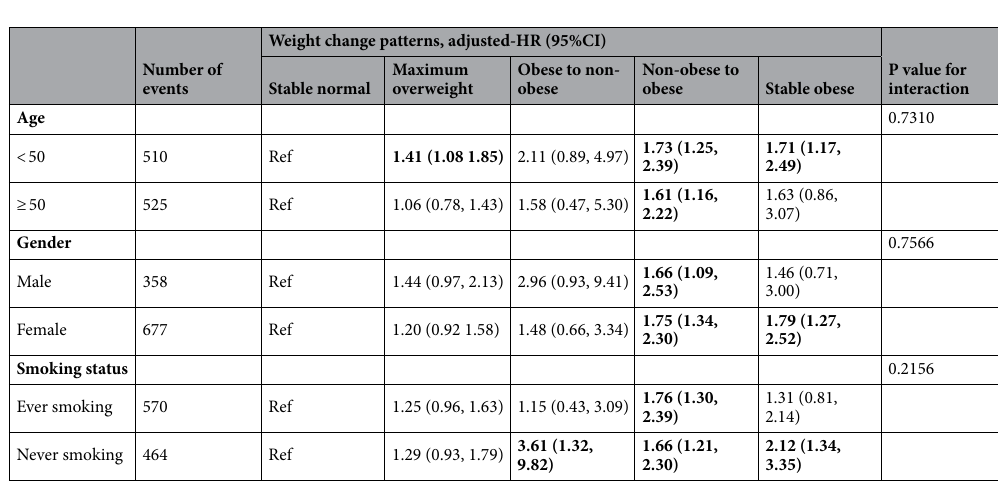
Table 6. Hazard ratios (HRs) and 95% confidence intervals (CIs) of incident asthma with weight change patterns across adulthood stratified by baseline age, gender and smoking status. All estimates accounted for complex survey designs and the analyses used the sample weights, stratification and clustering suggested by the CDC. Risk estimates were adjusted for gender (not adjusted in stratified analysis by gender), age at 10 years before baseline (not adjusted in stratified analysis by age), race/ethnicity, baseline family income, baseline education, and baseline smoking status (not adjusted in stratified analysis by smoking status). Significant results are in boldface